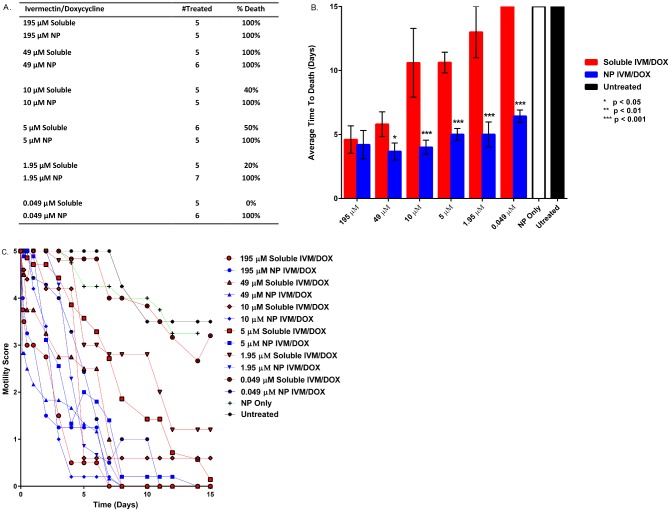
The motility of B. malayi MF treated with decreasing doses of either soluble or encapsulated ivermectin (IVM)/doxycycline (DOX) was recorded for 14 days post treatment.The recorded motility scores (Panel B) were used to calculate an average time to death for each treatment group and dose (Panel A). To calculate the average motility score for each time, dose and treatment group, triplicate wells containing a minimum of 200 MF in each well were treated as indicated. A motility score of 0 was equated with death and the average time to death was plotted along with standard error. Data presented are from one of two experiments with similar results. Significance was determined at p<0.05, 0.01, or 0.001 as noted using a Student’s T test.